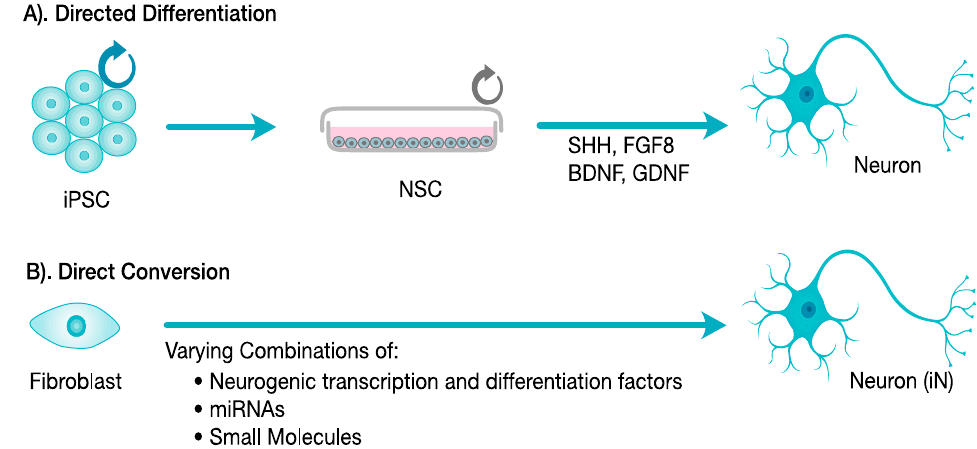
Figure 1. Directed differentiation vs. direct conversion methods to derive neurons. In Directed Differentiation ( A ) an iPSC is first created and then differentiated into a neural stem cell (NSC) that is self-renewing and can be induced to differentiate into neurons via the transcription and growth factors such as sonic hedgehog (SHH), fibroblast growth factor 8 (FGF8), which induce differentiate into dopaminergic neurons, brain-derived neurotrophic factor (BDNF), and glial-derived neurotrophic factor (GDNF) to promote neuronal maturation. In Direct Conversion ( B ) a somatic cell, such as a fibroblast, is directly converted into a neuron via a combination of neurogenic transcription and differentiation factors, miRNAs and small molecules, producing neurons called induced neurons (iNs).